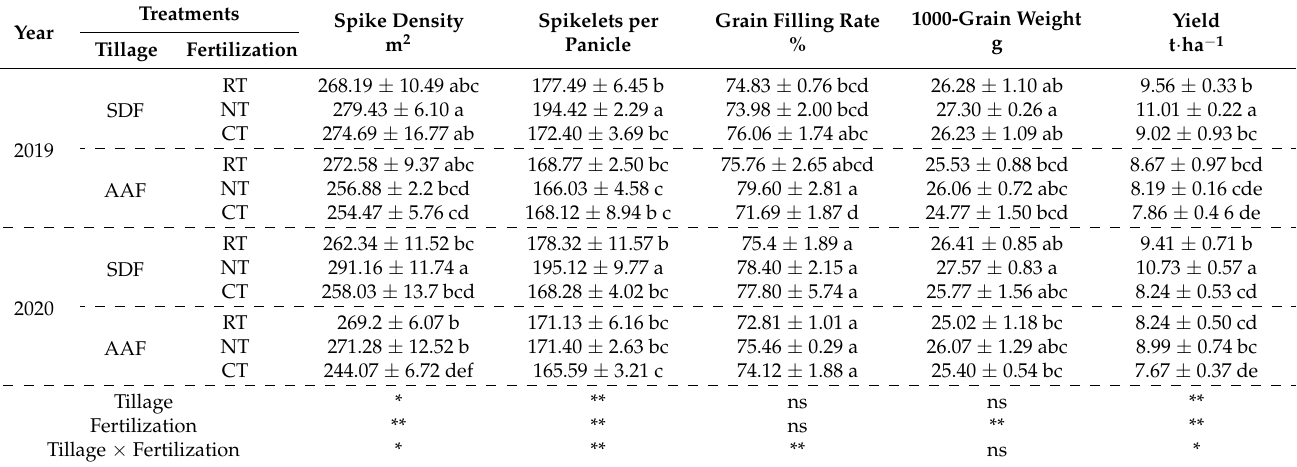
Table 1. Rice yield and its components under different tillage and fertilization treatments.